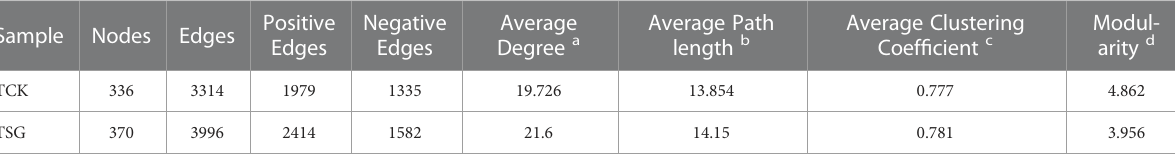
TABLE 2 Co-occurrence network properties within bacterial taxa in two groups of samples.